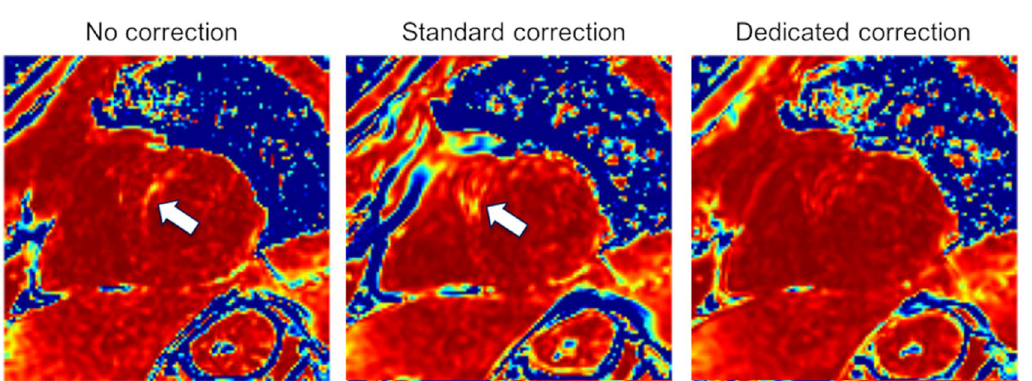
Figure 3. Coefficient of determination (R 2 ) maps of the T1 maps obtained from the same MOLLI series, using the three motion correction approaches compared in this study. Values from 0.95 to 1.00 are shown. The arrows indicate regions where myocardial motion resulted in decreased T1 accuracy, aggravated by misregistration with the standard correction method. These maps were created using Matlab (MathWorks, Natick,